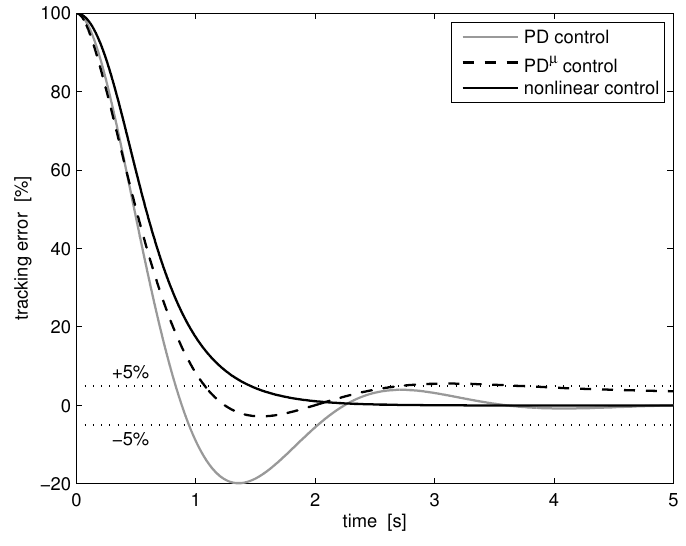
Figure 9. Tracking error,